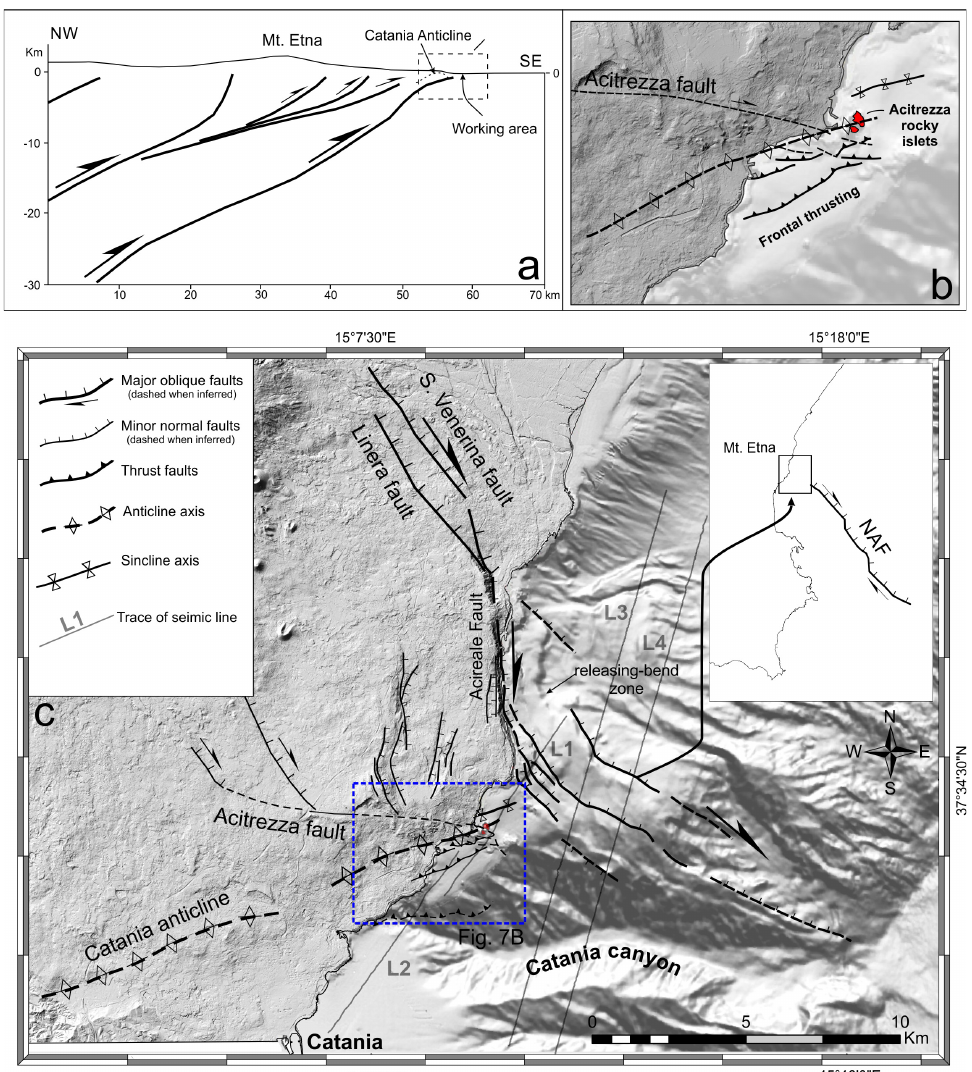
Figure 7. Tectonic interpretation of the investigated area based on high-resolution seismic profiles and available multibeam data [11]. ( a ) Reconstructed crustal section across Mt. Etna and the Catania Anticline (see Figure 1 a for location), showing the location of the contractional structures at the front of a deep-seated thrust ramp (see also [17,23]); ( b ) In the Aci Trezza offshore, ENE-WSW trending reverse faults deform the continental shelf. These structures are coaxial to the hinge of the Catania Anticline and, therefore, they have been interpreted as its frontal thrusting; ( c ) Towards the NE, the detected extensional fault system appears nucleated within a releasing zone formed at bending of a major transtensional faults. The latter include the seismogenic Timpe Fault System, here interpreted as the continuation toward the mainland of the North Alfeo Fault